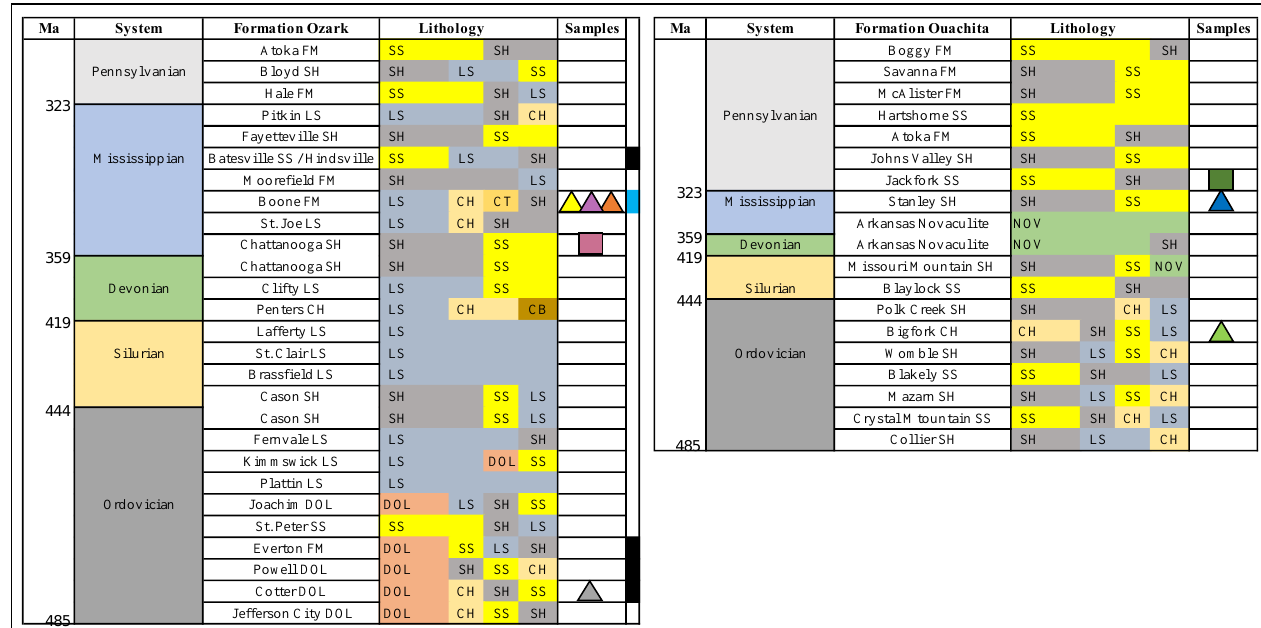
Figure 3. Generalized stratigraphic sections of the units and component lithologies in the Ozark Region ( left ) and the Ouachita Mountains ( right ). Additionally shown are the stratigraphic locations of samples analyzed for this study (triangles) and previous studies [9,10], and the hosts of the Northern Arkansas and the Tri-State ores (black and blue bars, respectively). The height of the columns is not intended to represent the thicknesses of the units. Information on the units and lithologies is from: https://www.geology.arkansas.gov/geology/stratigraphy.html (accessed on 29 December 2020). Modified from [10].